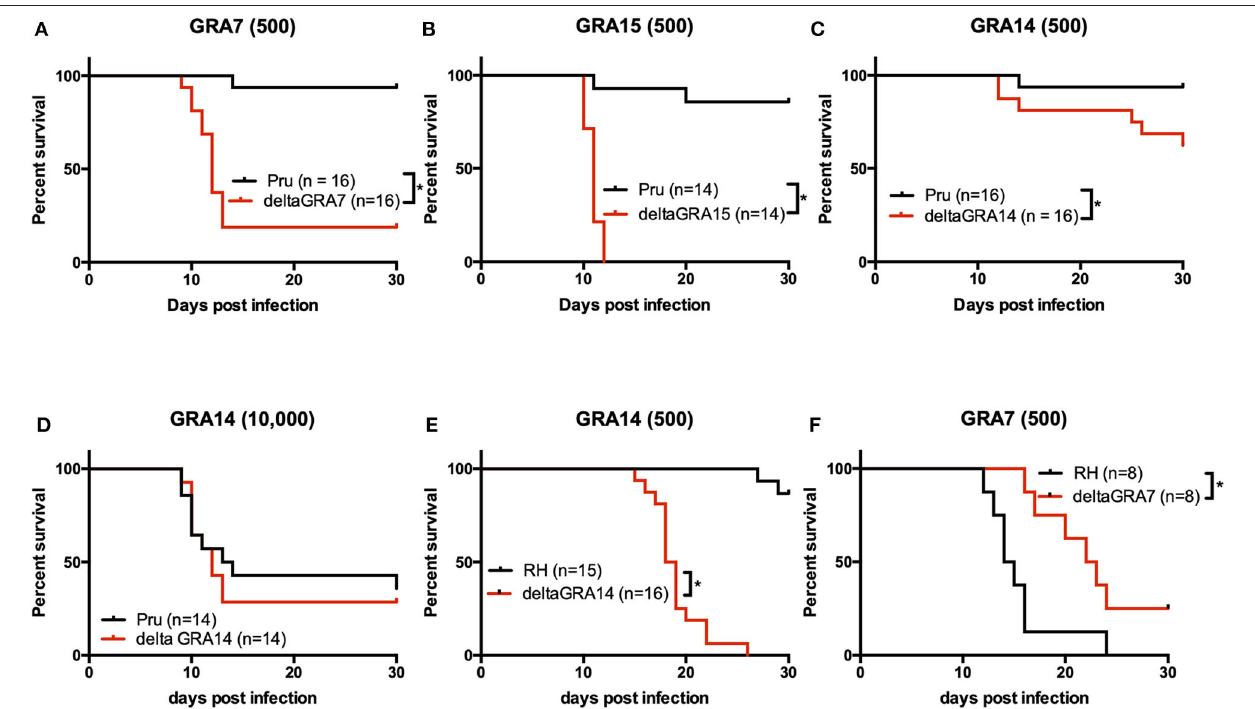
FIGURE 7 | Survival in mice infected with T. gondii. (A–E) Mice were intraperitoneally infected with a low dose (500) or a high dose (10 4 ) of T. gondii tachyzoites of parasites strains, and survival was monitored for 30 days. (A) Survival rate of mice infected with 500 tachyzoites. In total, 16 mice were infected per strain (6 + 10). Data are summarized from two independent experiments. (B) Survival rate of mice infected with 500 tachyzoites. In total, 14 mice were infected per strain (6 + 8). Data are summarized from two independent experiments. (C) Survival rate of mice infected with 500 tachyzoites. In total, 16 mice were infected per strain (6 + 10). Data are summarized from two independent experiments. (D) Survival rate of mice infected with 10 4 tachyzoites. In total, 14 mice were infected per strain (6 + 8). Data are summarized from two independent experiments. Statistical analysis was performed using a log rank test ( p < 0.05). (E) Mice were infected via the intra-footpad route with 500 T. gondii tachyzoites of the RH 1 gra14 mutant and its parental strain, and survival was monitored for 30 days. In total, 15 and 16 mice were infected per strain (RH, 7 + 8; RH 1 gra14 , 8 + 8). (F) Mice were infected via the intra-footpad route with 500 T. gondii tachyzoites of the RH 1 gra7 mutant and its parental strain, and survival was monitored for 30 days. In total, 8 and 8 mice were infected per strain (RH, 8; RH 1 gra7 , 8). This experiment was performed once. Statistical analysis was performed using the log rank test ( p < 0.05). *indicates a significant